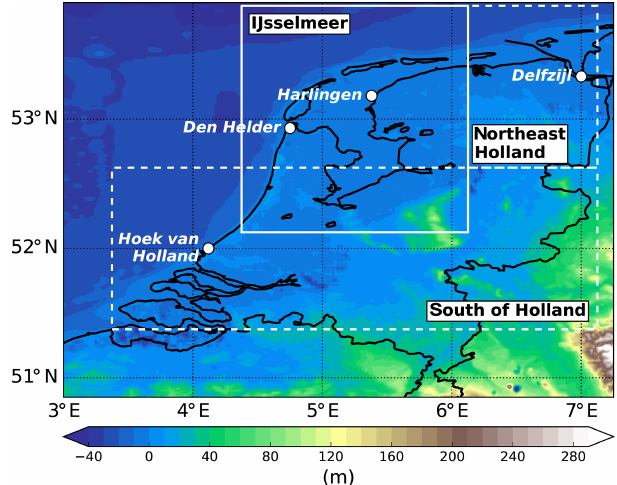
Figure 1. Topographical map of the study area showing the geo- graphic location of the four coastal stations under investigation in this study. White boxes indicate the three regions that were con- sidered for local precipitation, i.e. south of Holland for Hoek van Holland, IJsselmeer for Den Helder and Harlingen and northeast Holland for Delfzijl. Elevation data are derived from the ETOPO1 Global Relief Model (Amante and Eakins,